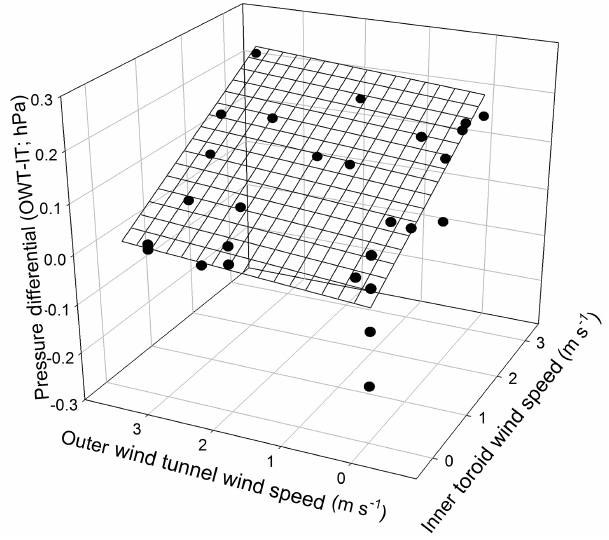
Figure 2. The relationship between wind speed and measured pressure differential (outer wind tunnel minus inner toroid). The planar surface indicates best fit to data ( r 2 = 0 . 63, z (hPa) = − 0 . 03 + 0.07 × IT WS (ms − 1 ) + 0 . 01 × OWT WS (ms − 1 )). Note insensitivity of pressure to external wind